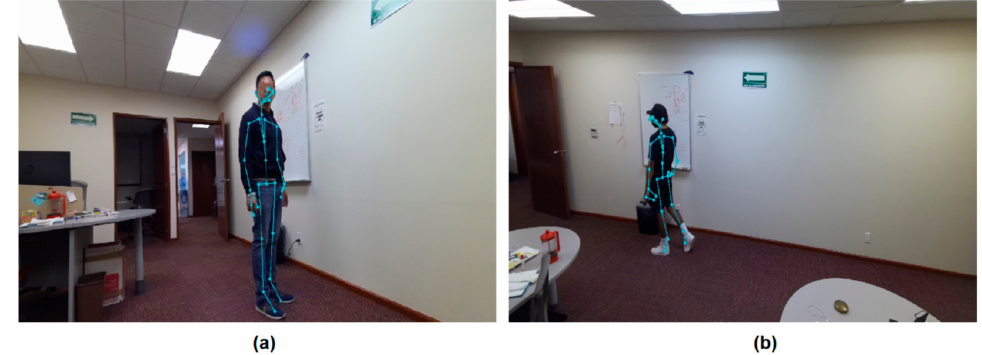
Figure 15. ( a ) Camera/depth sensor position 2 view; ( b ) camera/depth sensor position 3 view.